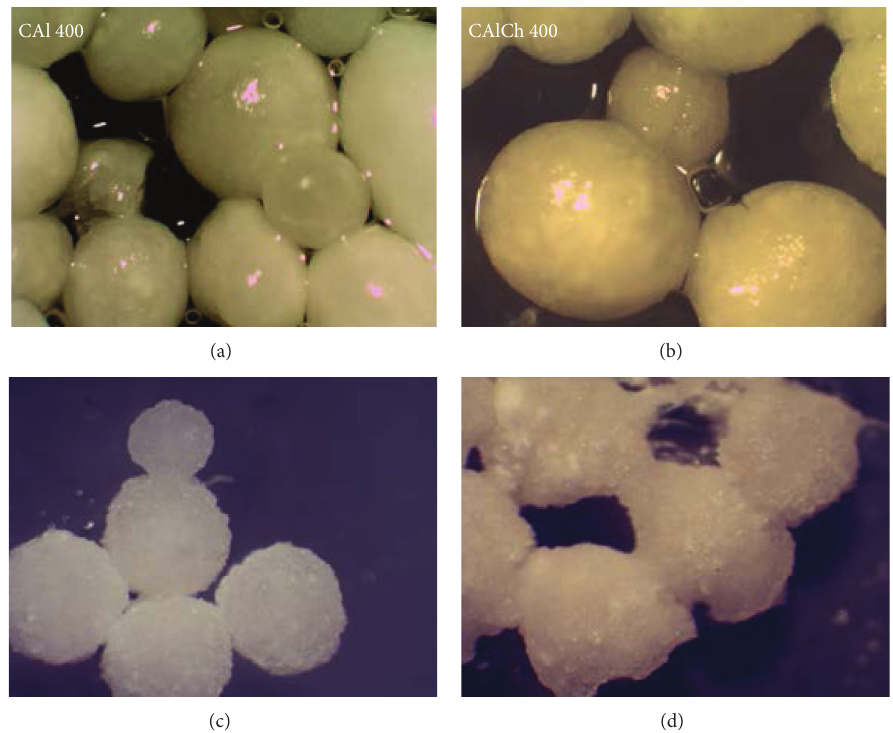
Figure 2: Stereomicroscopic images of wet (a-b) (2x magnification) and dry (c-d) (3x magnification) beads obtained using a needle of 400 𝜇 m